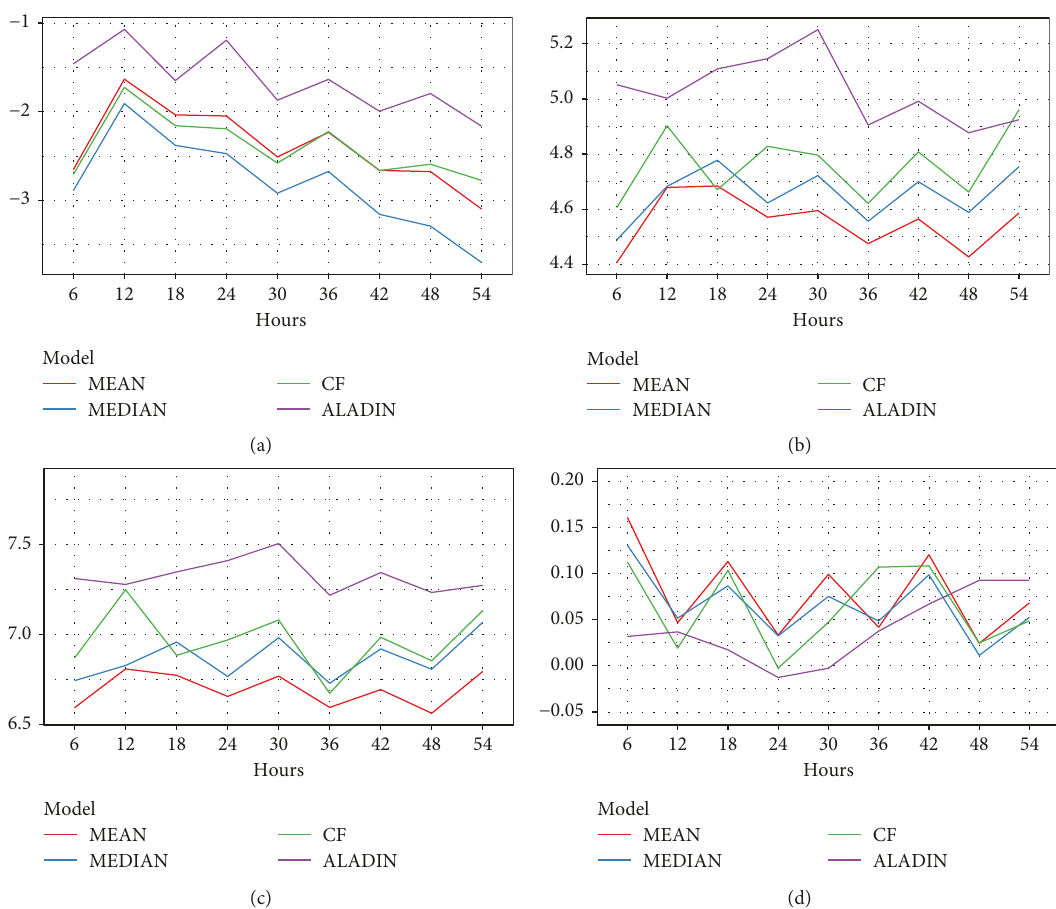
Figure 2: Comparison of ALADIN (purple), MEAN (red), MEDIAN (blue), and CF (green) for ME (a), MAE (b), RMSE (c), and COR (d) as a function of lead time. Grey lines represent 16 ensemble